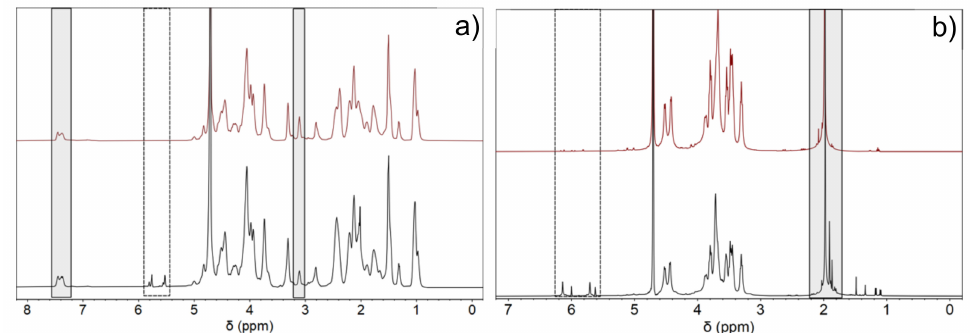
Figure 1. NMR spectra of ( a ) Gel (—) and GelMA (—) and (b) HA (—) and HAMA (—). In ( a ) and ( b ), the dotted rectangles denote the presence of the methacryloyl peaks after successful modification. In ( a ), the grey rectangle at ca. 7.1–7.5 ppm denotes the phenylalanine peaks taken as reference, whereas that one drawn at 3.0–3.3 ppm corresponds to the decrease of lysine groups. In ( b ), the grey rectangle indicates the methyl groups of HA at ca. 2.0 ppm taken as reference and the appearance of methyl protons of methacrylate at ca. 1.9 ppm,